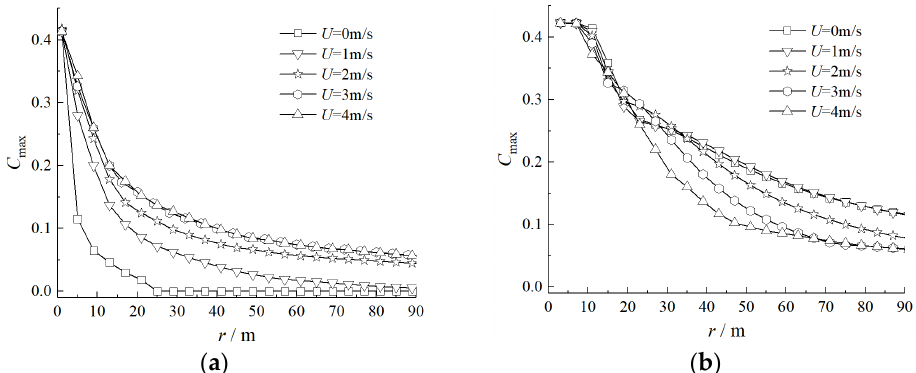
Figure 19. Attenuation of C max along the r direction for various U : ( a ) vertical discharge pattern; ( b ) horizontal discharge pattern.